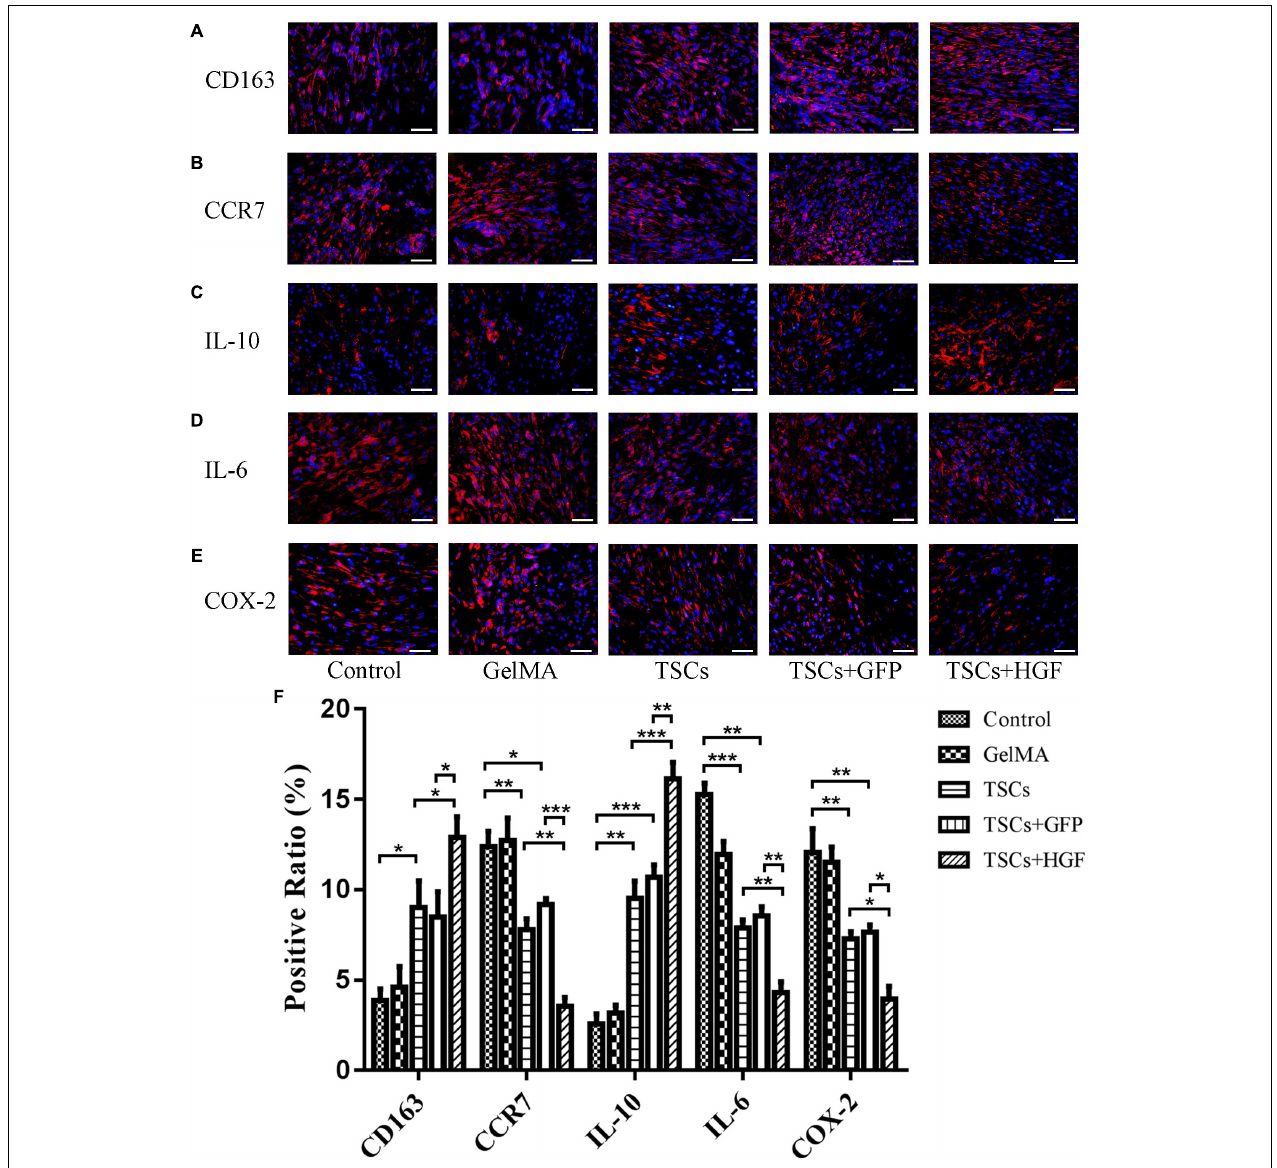
FIGURE 3 | Impact of TSCs + HGF on tendon inflammation. Immunohistochemical representative images of (A) CD163 + cells, (B) CCR7 + cells, (C) IL-10 + cells, (D) IL-6 + cells, and (E) COX-2 + cells at 1 week postoperative repair site. (F) Positive cell ratio of inflammation-related factors at 1 week ( n = 5). Bars: 50 µ m. Data are represented as mean ± SD. * P < 0.05, ** P < 0.01, *** P < 0.001.